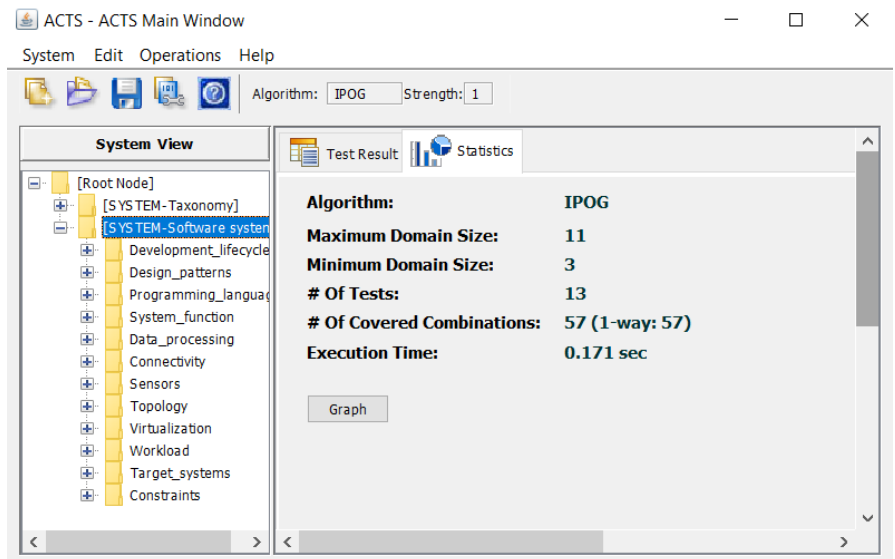
Figure 7. Building classification trees and combinatorial testing with Automated Combinatorial Testing for Software